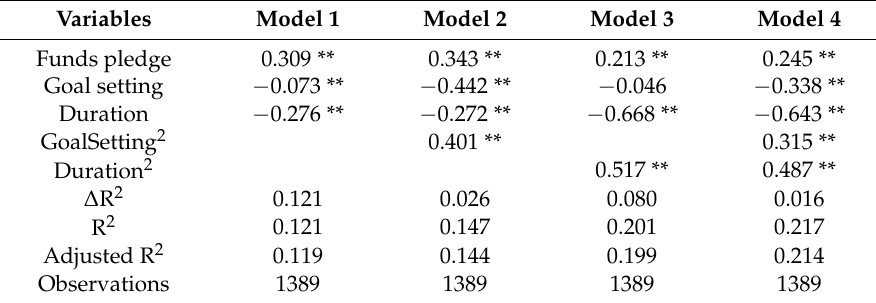
Table 2. Results of research model.